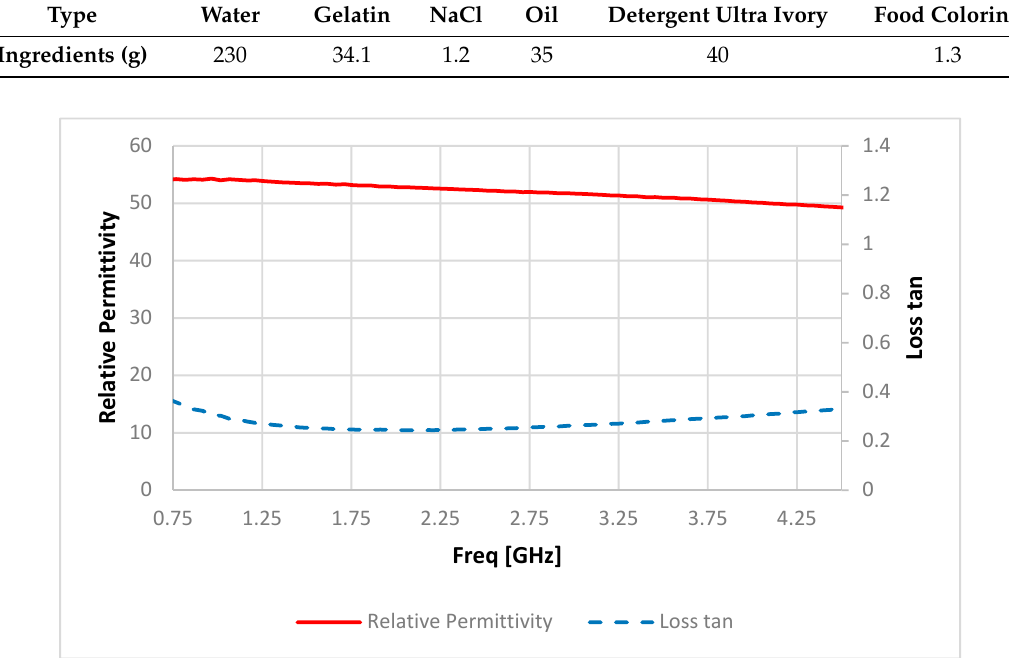
Figure A1. Measured relative permittivity and loss tangent of fabricated muscle phantom.